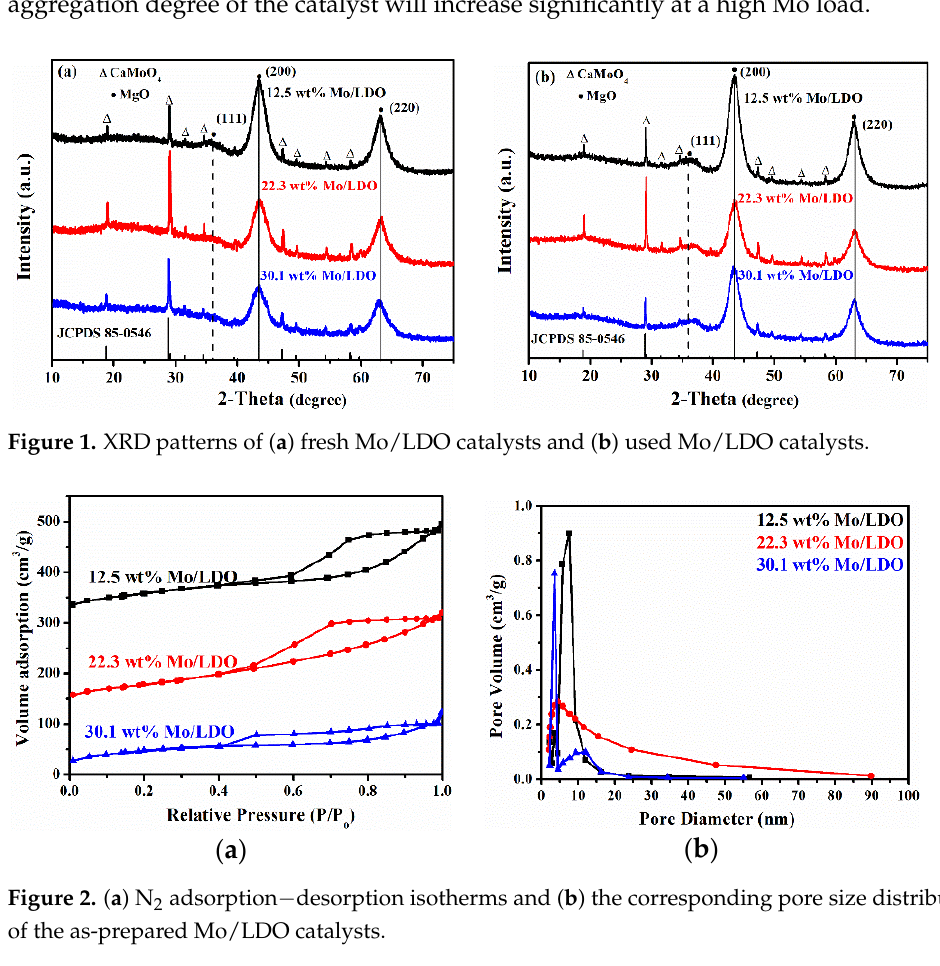
Figure 1. XRD patterns of ( a ) fresh Mo/LDO catalysts and ( b ) used Mo/LDO catalysts.